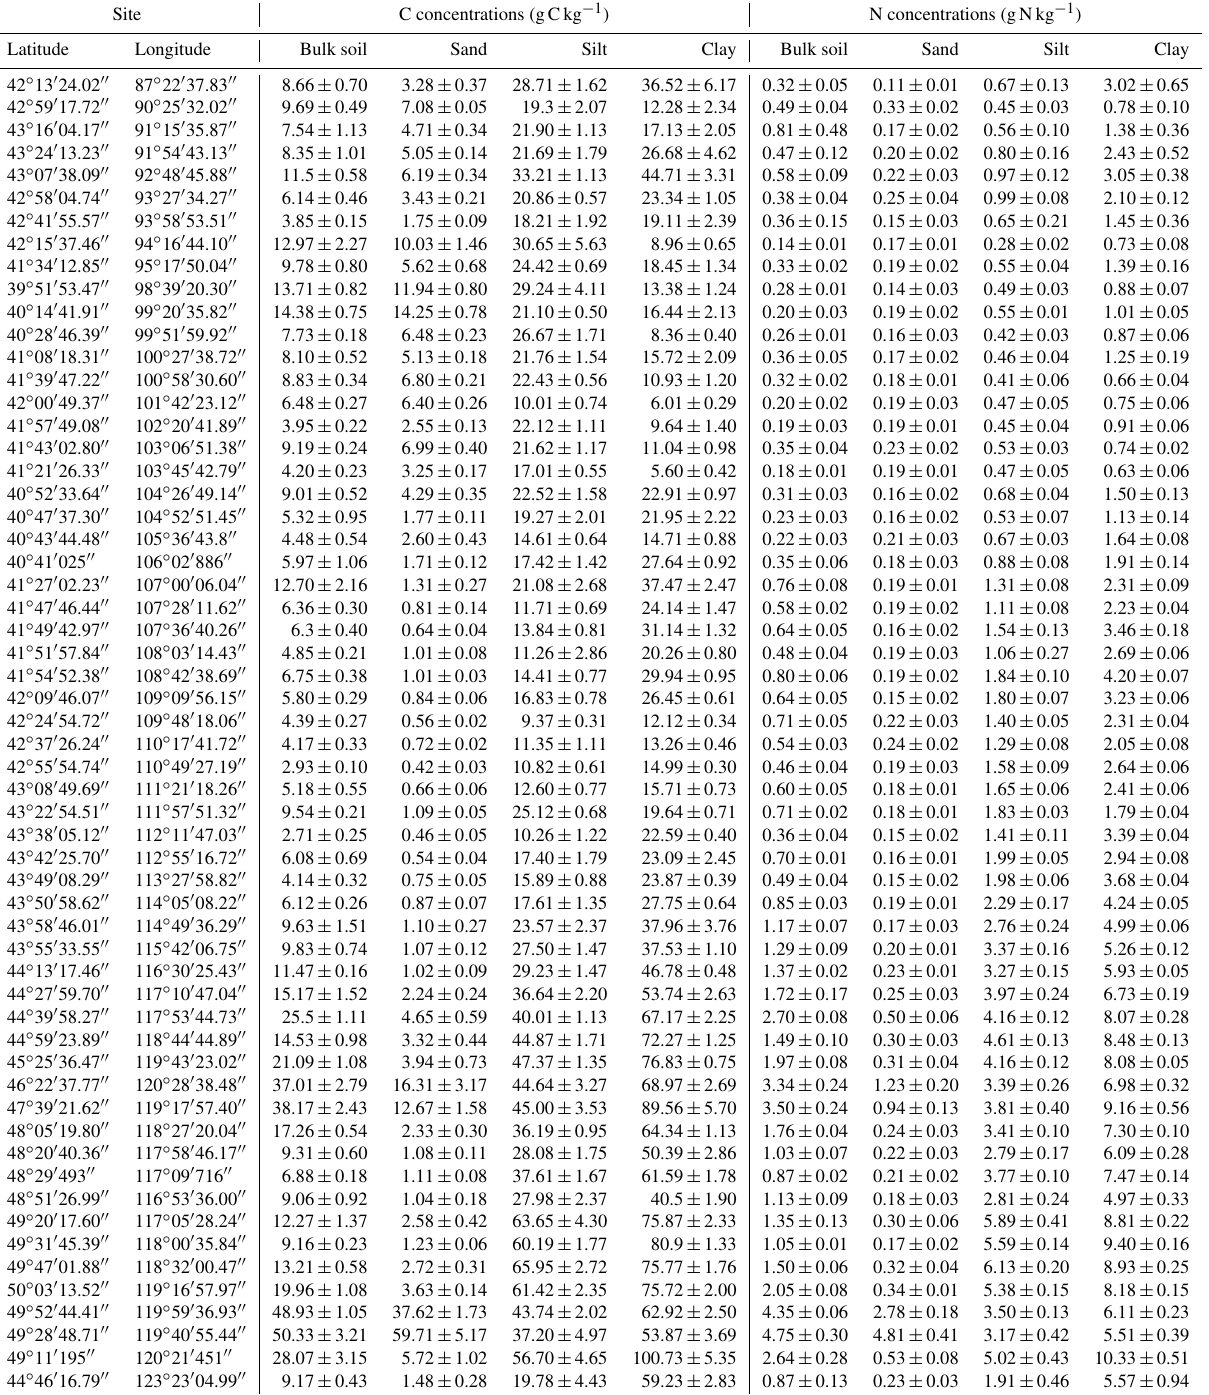
Table 1. Soil C and N concentrations in bulk soils and different soil particle–size fractions (sand, silt and clay) at 58 sampling sites in arid and semi-arid grasslands of northern China (data are represented as means ± 1SE, n = 5). Site C concentrations (gCkg − 1